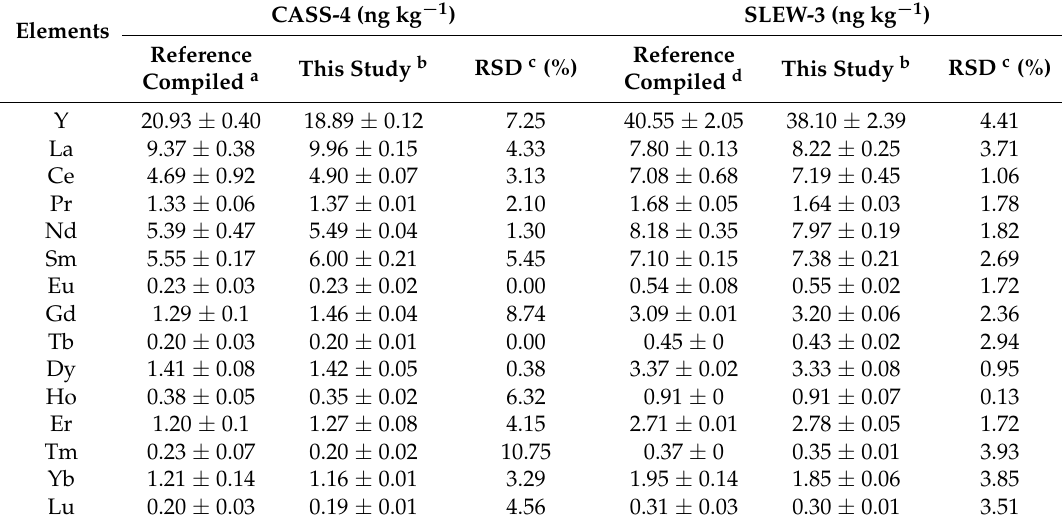
Table 1. YREEs concentrations in CASS-4 (Salinity = 30.7) and SLEW-3 (Salinity = 15) from references and this study.